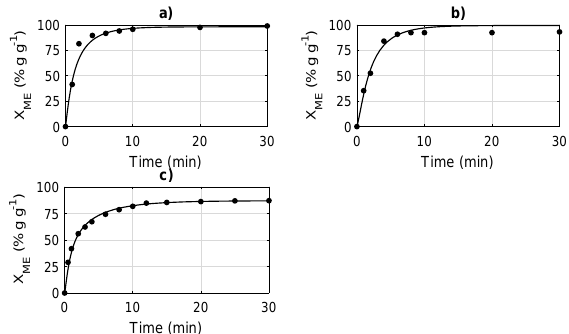
Figure 3. Experimental vs. simulation data for the transesterification reactions for different vegetable oils. Mass fraction of methyl esters during the transesterification reaction of the following: ( a ) palm oil (60 ◦ C, 1 wt% catalyst), ( b ) mustard oil (60 ◦ C, 1 wt% catalyst), and ( c ) sunflower oil (35 ◦ C, 0.5 wt% catalyst)